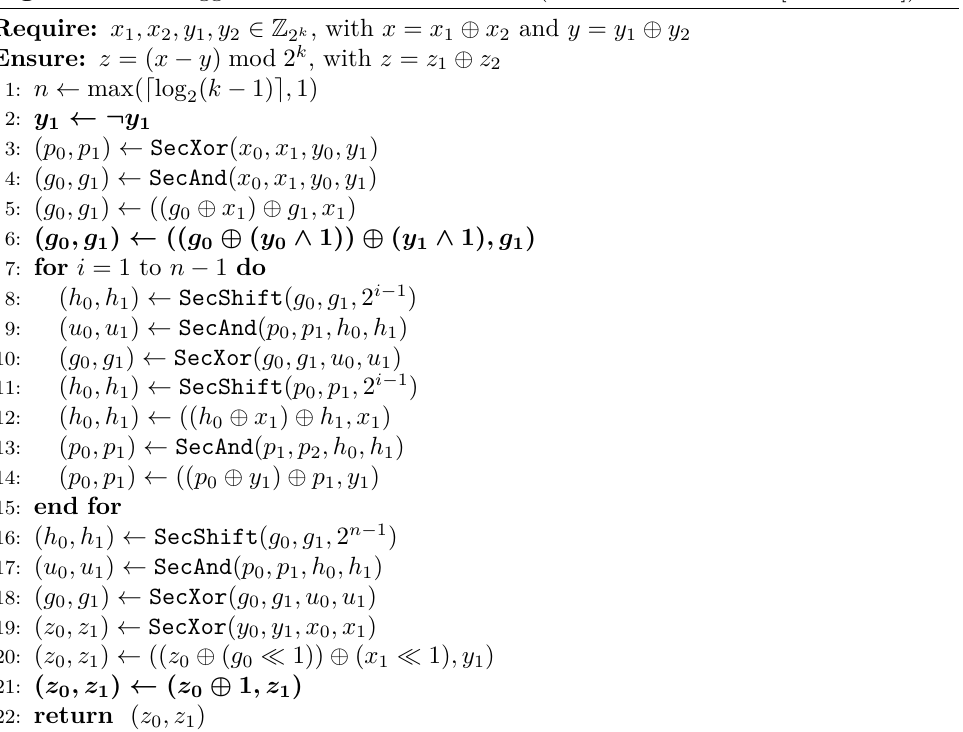
Algorithm 13 Kogge-Stone Masked Subtraction (based on adder from